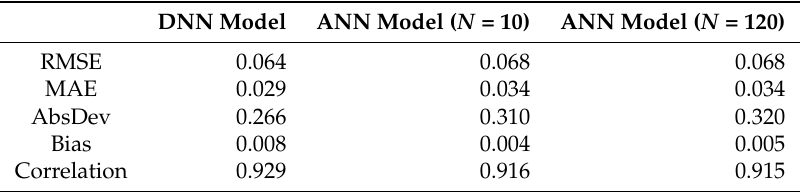
Table 10. Comparison with ANN models with a single hidden